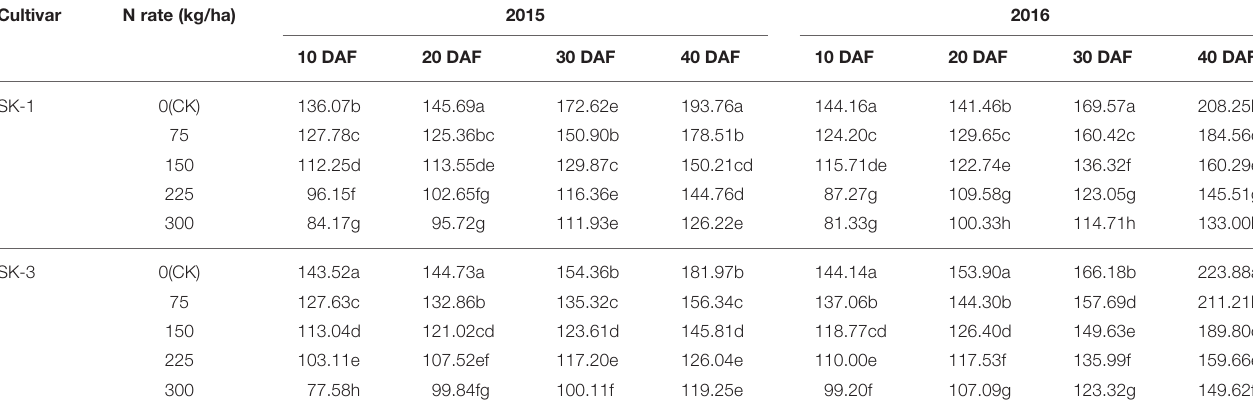
Symbol SK-1 and SK-3 are cultivar Sikang1 and Sikang3 respectively, CK is Control. DAF is acronym of “days after flowering.” Same letter among treatments within each sampling date represent non-significant difference (LSD test at 0.05 significance level).